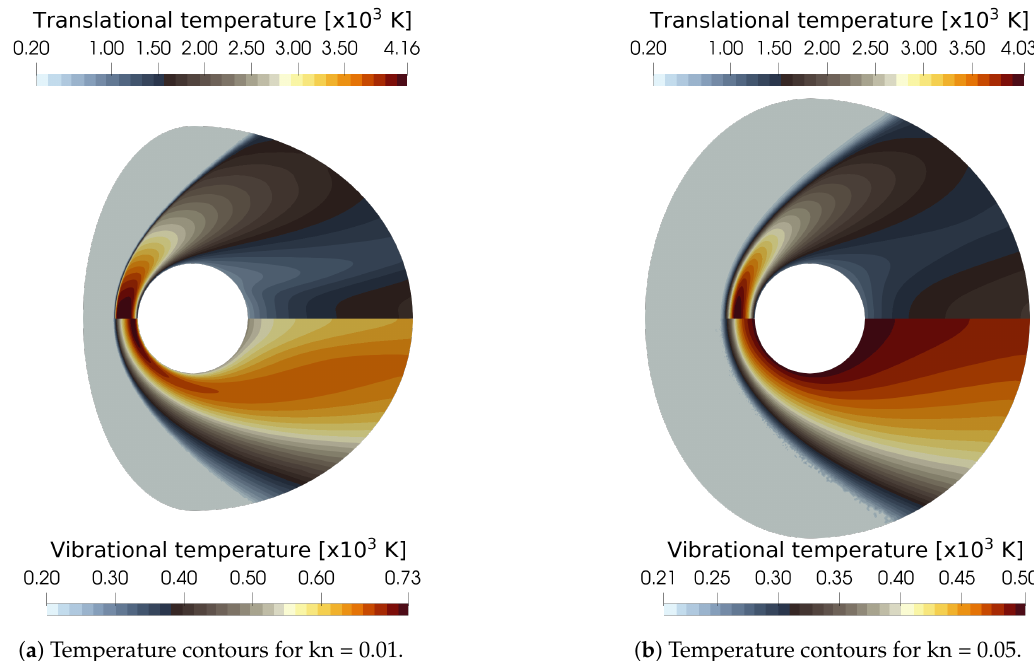
Figure 14. Temperature contours of an N 2 hypersonic gas flow over a